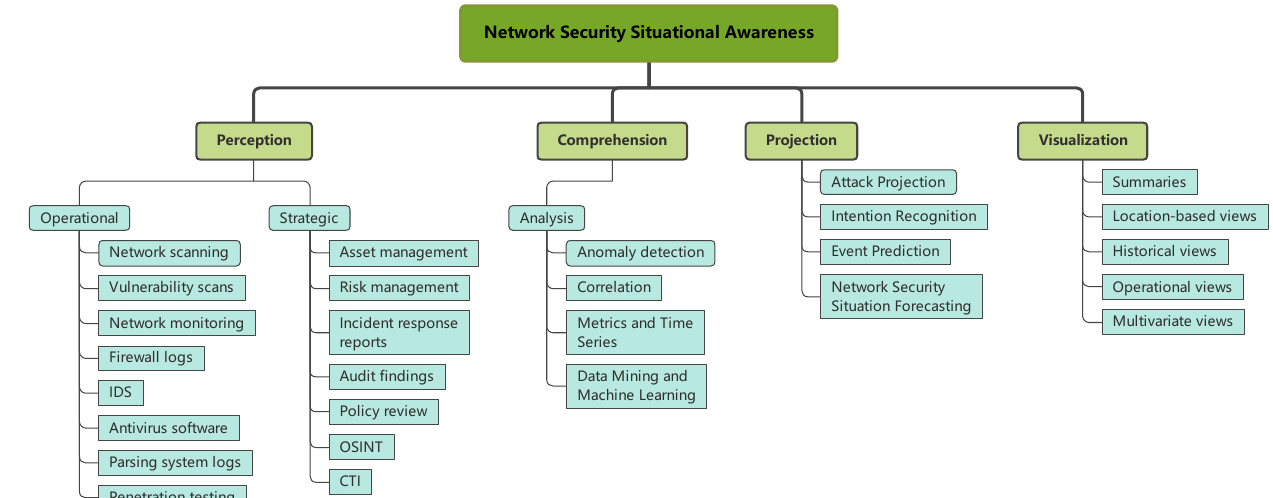
Figure 5. Taxonomy of NSSA tools and components.